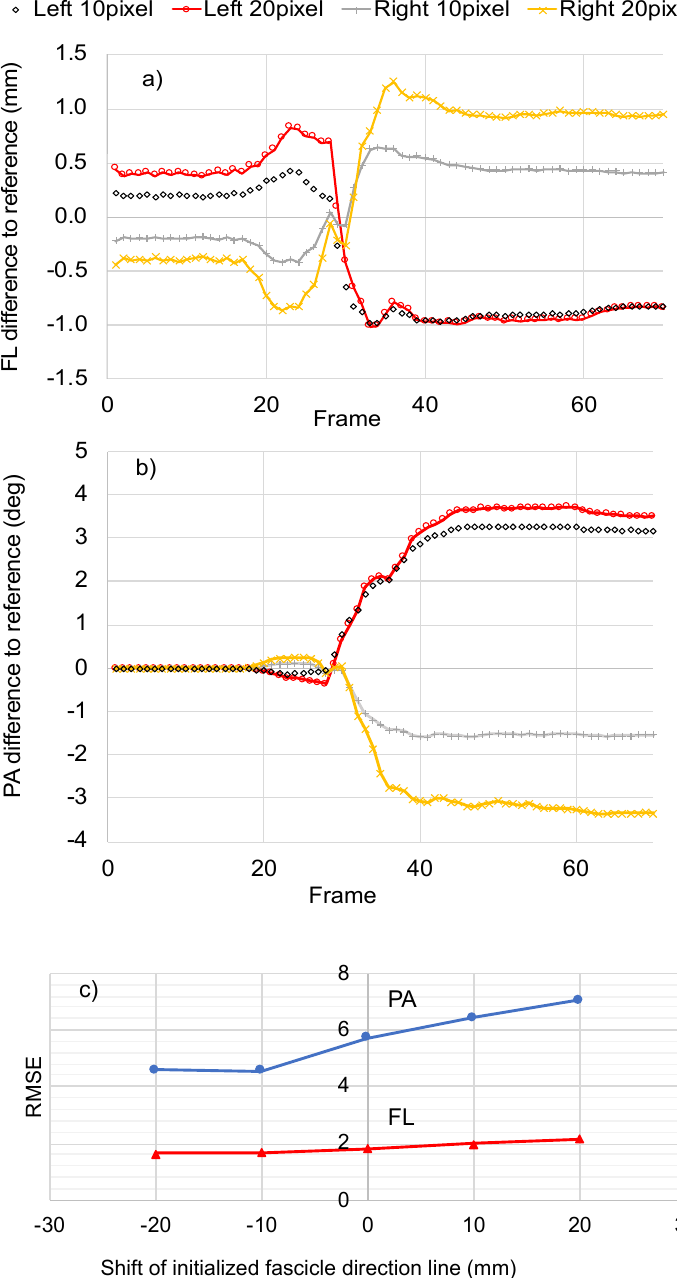
Figure 8. The sensitivity of FL and PA to the initial placement of the fascicle direction line initialization.